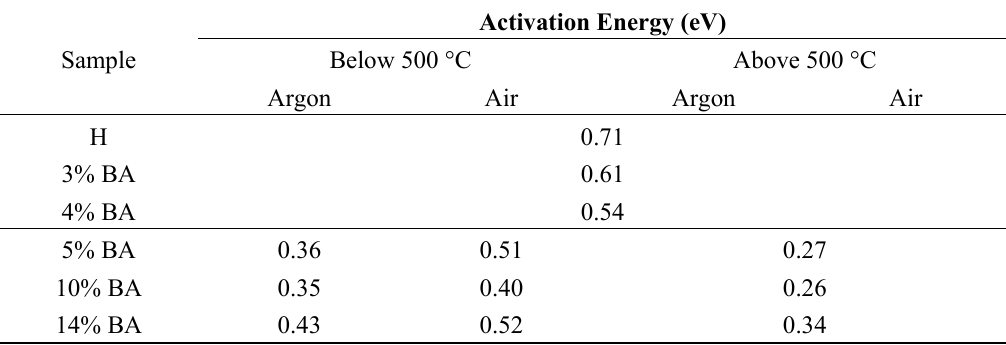
Table 3. Activation energies calculated from the linear regions of the Figure 6.